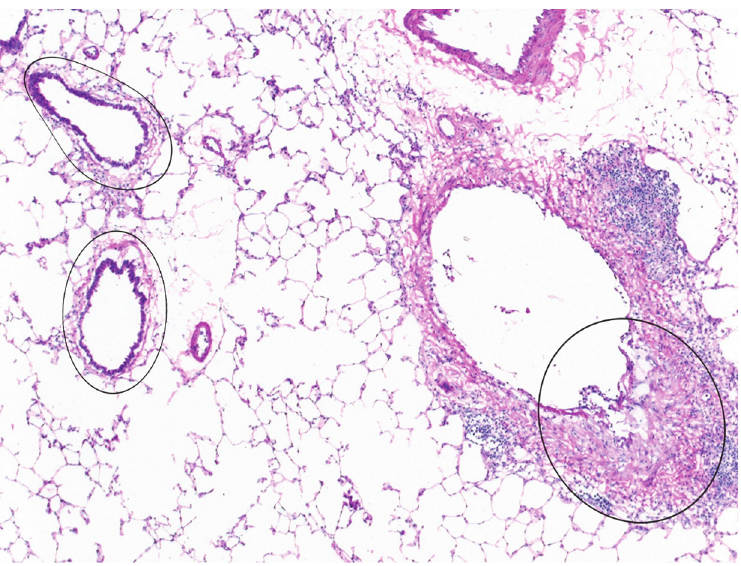
Fig 1. Laser capture microdissection (LCM) of fibrotic and non-fibrotic bronchi. Microdissection of fibrotic bronchial lesions, such as that indicated by the circled area on the right, was performed on frozen sections. Similarly, exposed but non-fibrotic bronchi, such as the two noted on the left, were microdissected and collected separately. RNA was subsequently extracted from both the fibrotic and the non-fibrotic bronchial specimens, and utilized for microarray and PCR analysis. 4x original objective